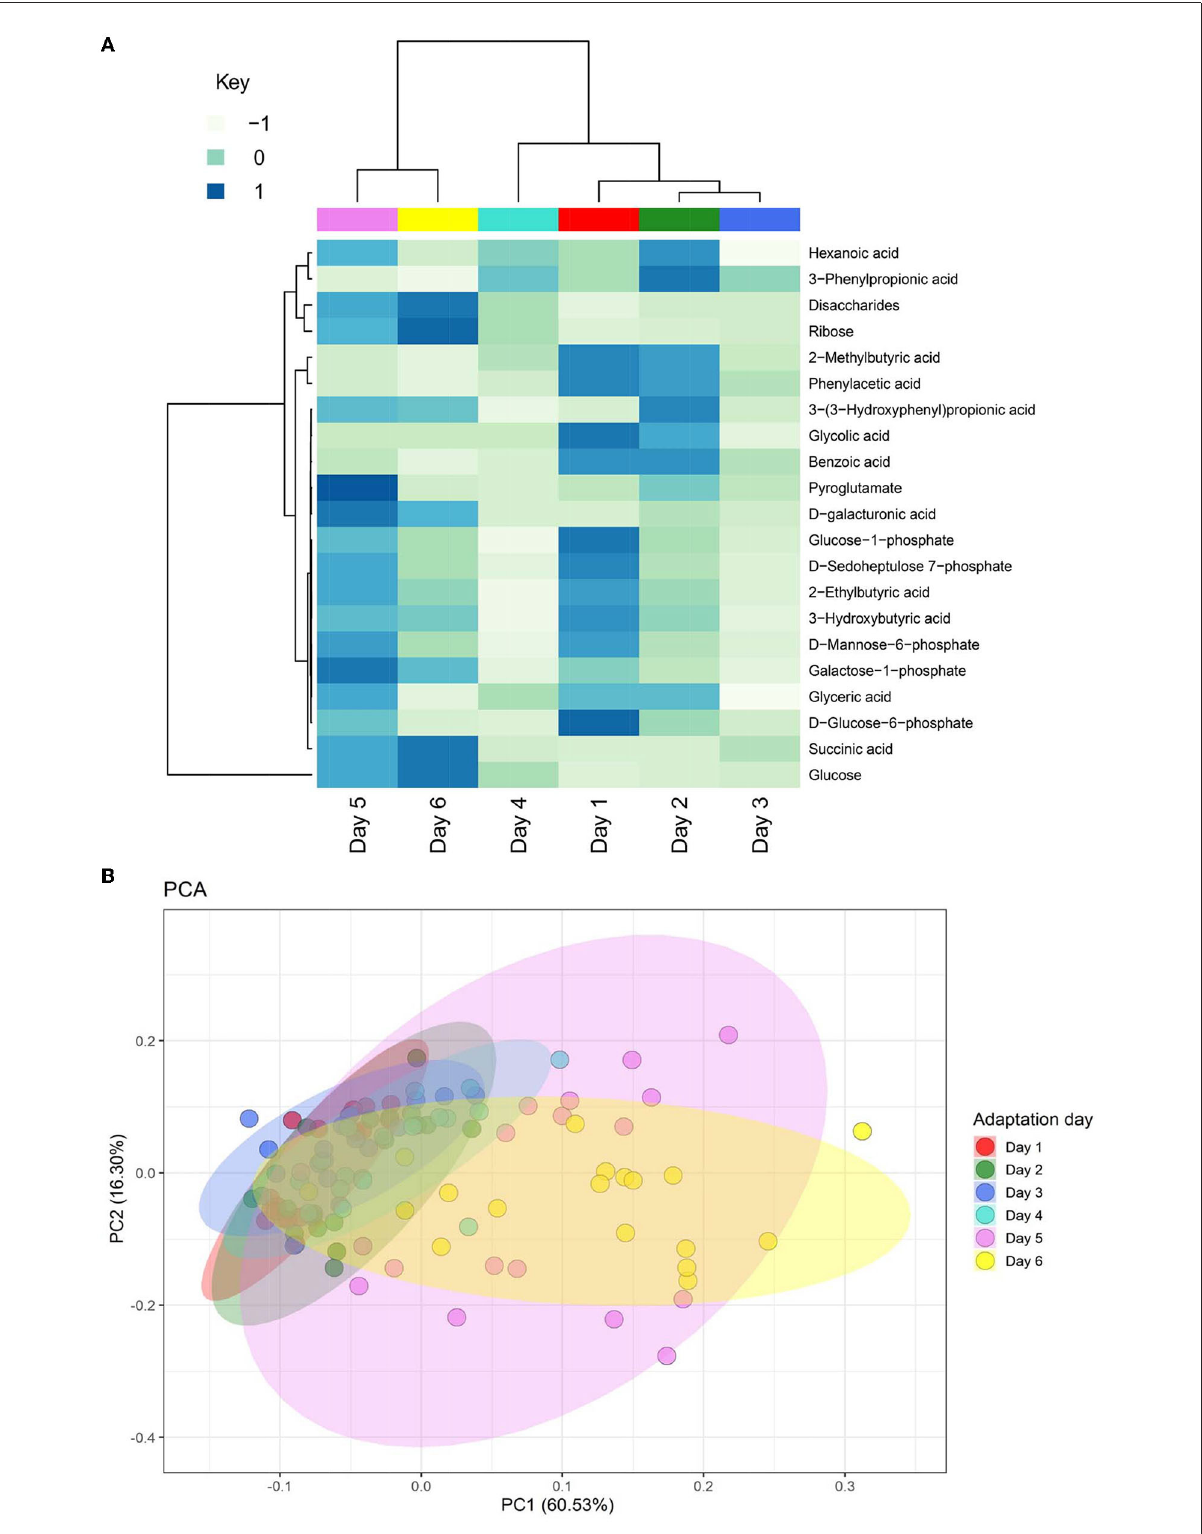
FIGURE5 Heatmap (A) showing the change in concentration of metabolites measured in the rumen fluid across the six experimental days. Rows were scaled to have mean zero and standard deviation one, to normalize the different concentrations of each metabolite. Values range from −